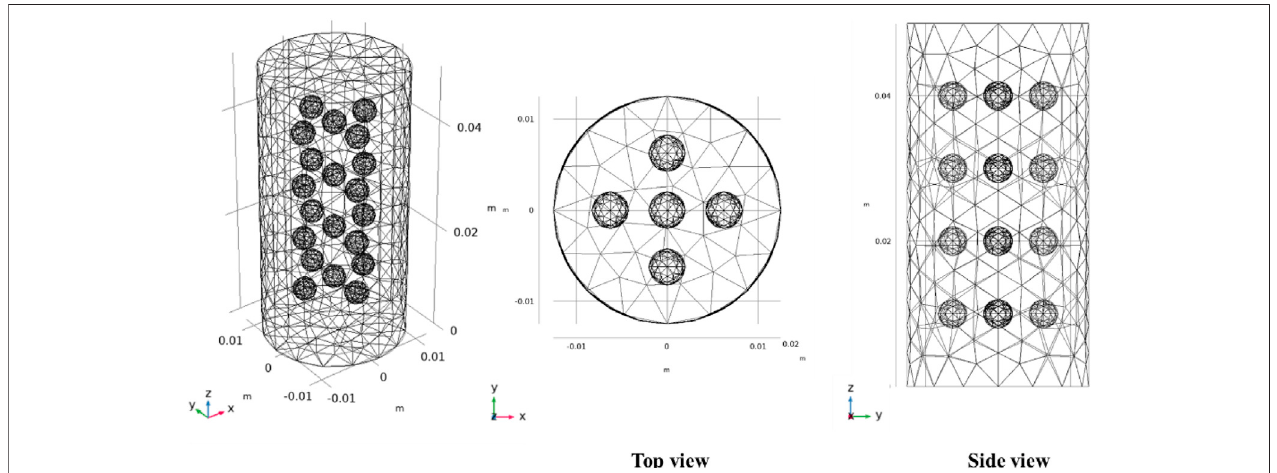
FIGURE 6 | Schematic of the simpli fi ed geometry for conglomerate compression simulation.